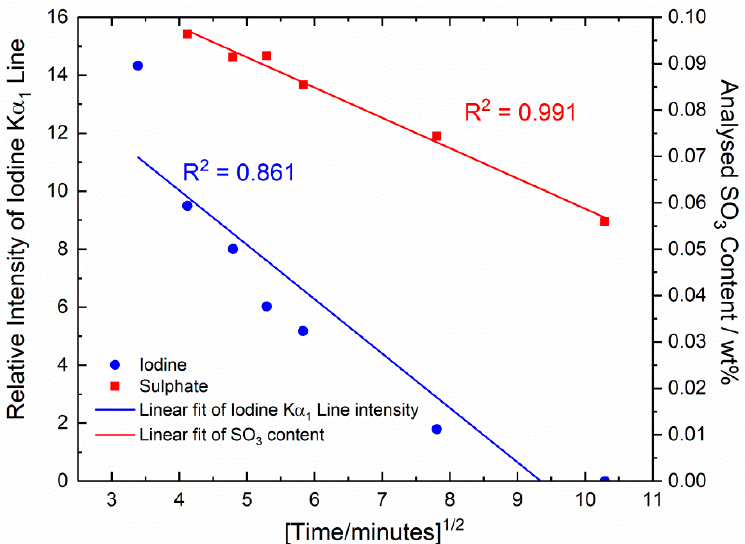
Figure 5. Relative intensity of iodine K α 1 line (IQ+ program) and analysed SO 3 content (OXI program), measured for Anorthic Feldspar (CRM-529 [40]) fused bead samples as a function of (melting time) 1/2 . Linear fits and associated R 2 values are marked.